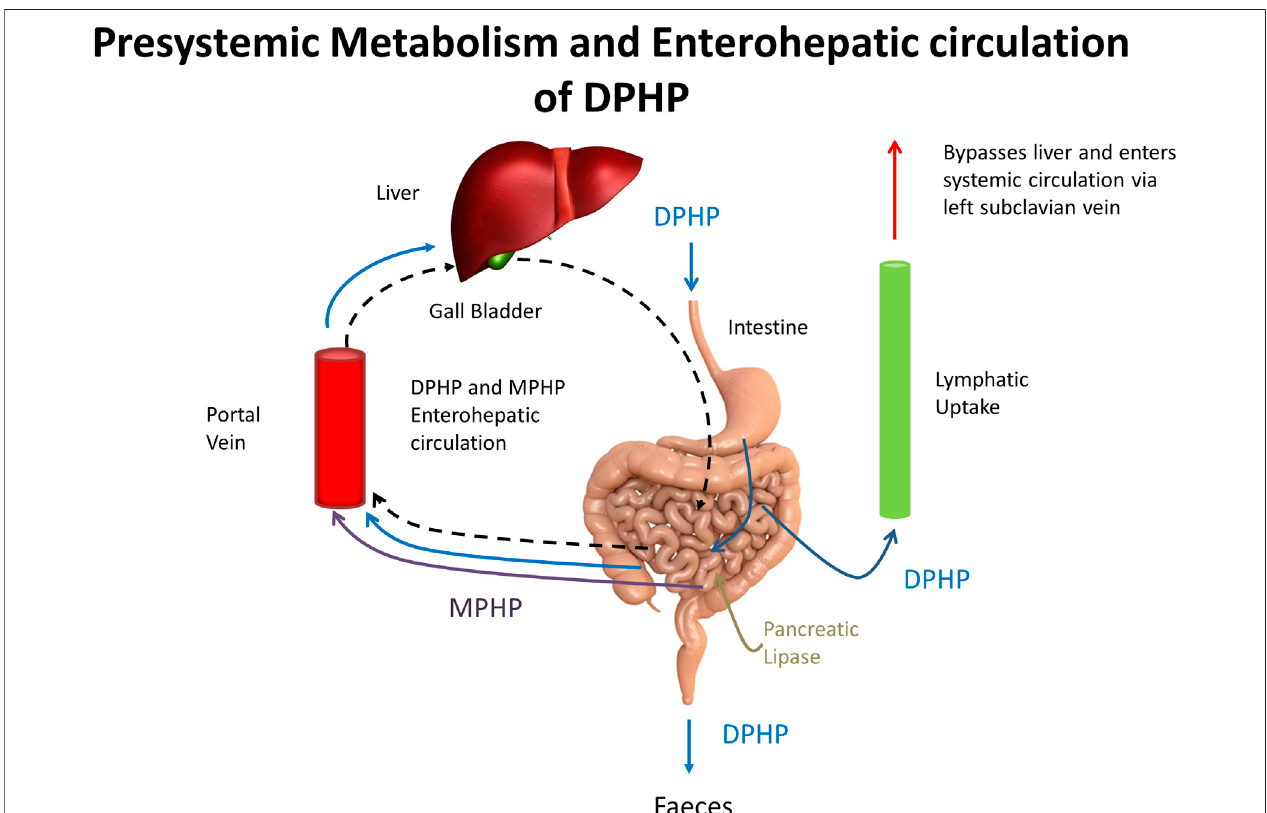
FIGURE 3 | A schematic showing pre-systemic metabolism and enterohepatic recirculation, systemic and lymphatic uptake of DPHP and uptake of MPHP from gastrointestinal tract.